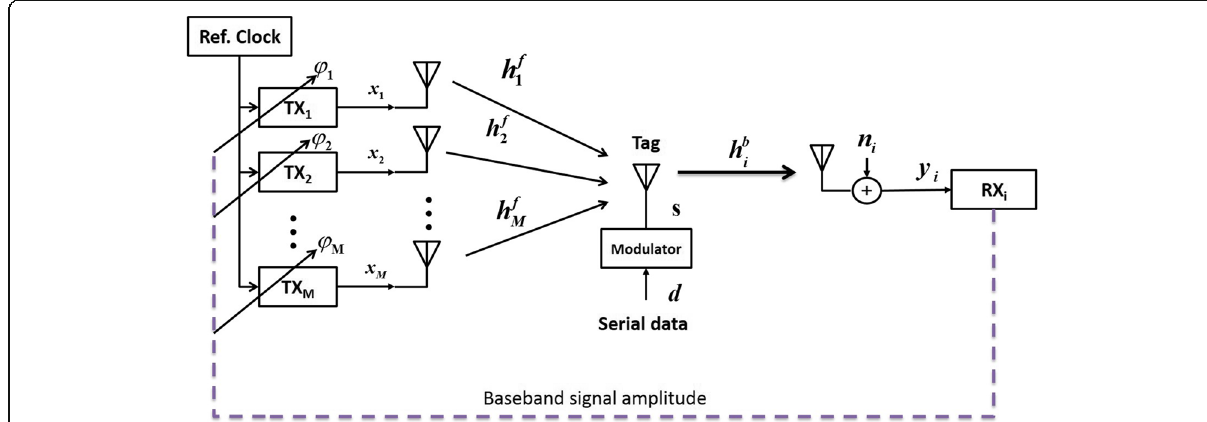
Fig. 3 Illustration of M × 1 × 1 backscatter communication system with a common reference clock. The dashed line shows feedback implementation for coherent focusing of signals at the tag